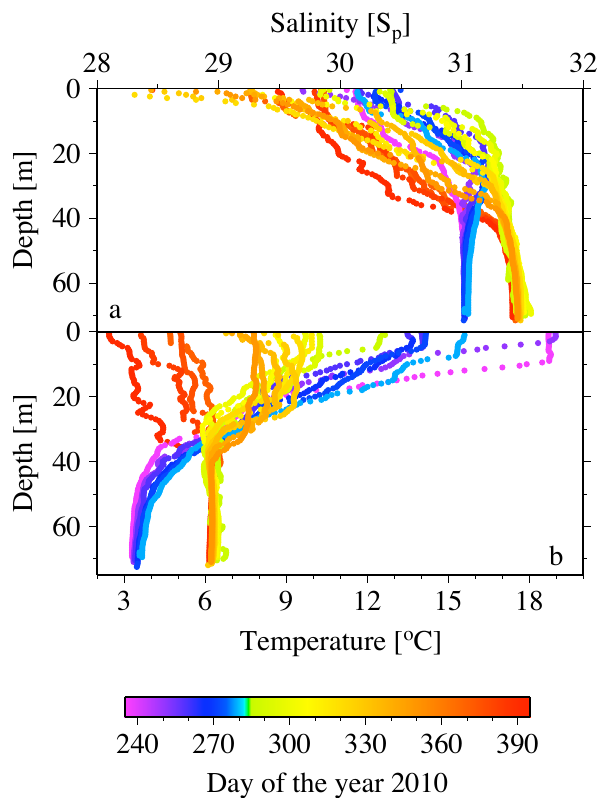
Fig. 2. Weekly vertical profiles of salinity ( S p ) (a) and temperature (b) from August 2010 (day 237)–January 2011 (day 391). The color bar has been adjusted at day 282 (9 October) in order to better illus- trate the abrupt changes in the deep waters around that day.